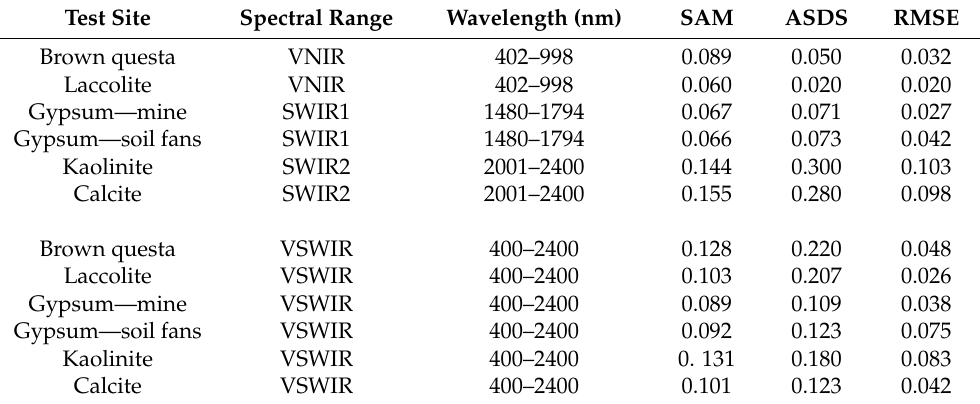
Table 4. SAM, ASDS, and RMSE values for each test